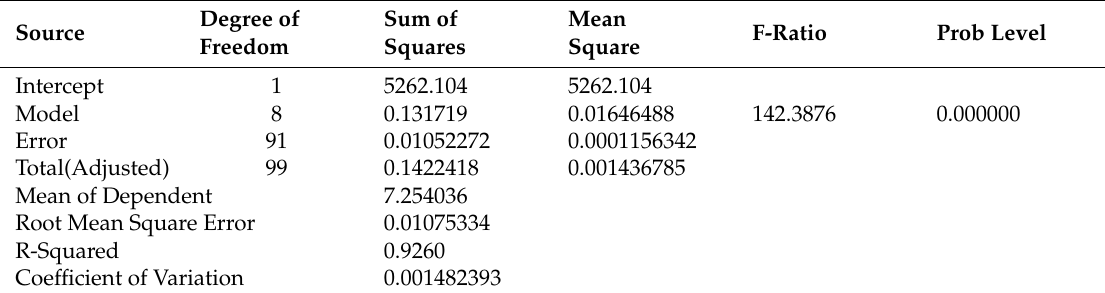
Table 4. Analysis of variance for k =